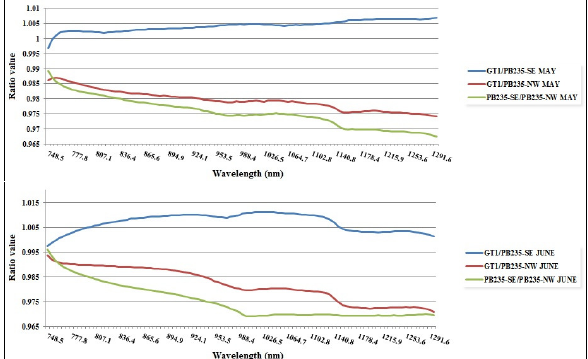
Figure 15. Ratios among spectra of the Rubber trees stands (GT1, PB235-SE and PB235-NW) from 740 to 1,300nm for May and June, in leaf scale 3.3 Shortwave Infra-red – SWIR (1,400 a